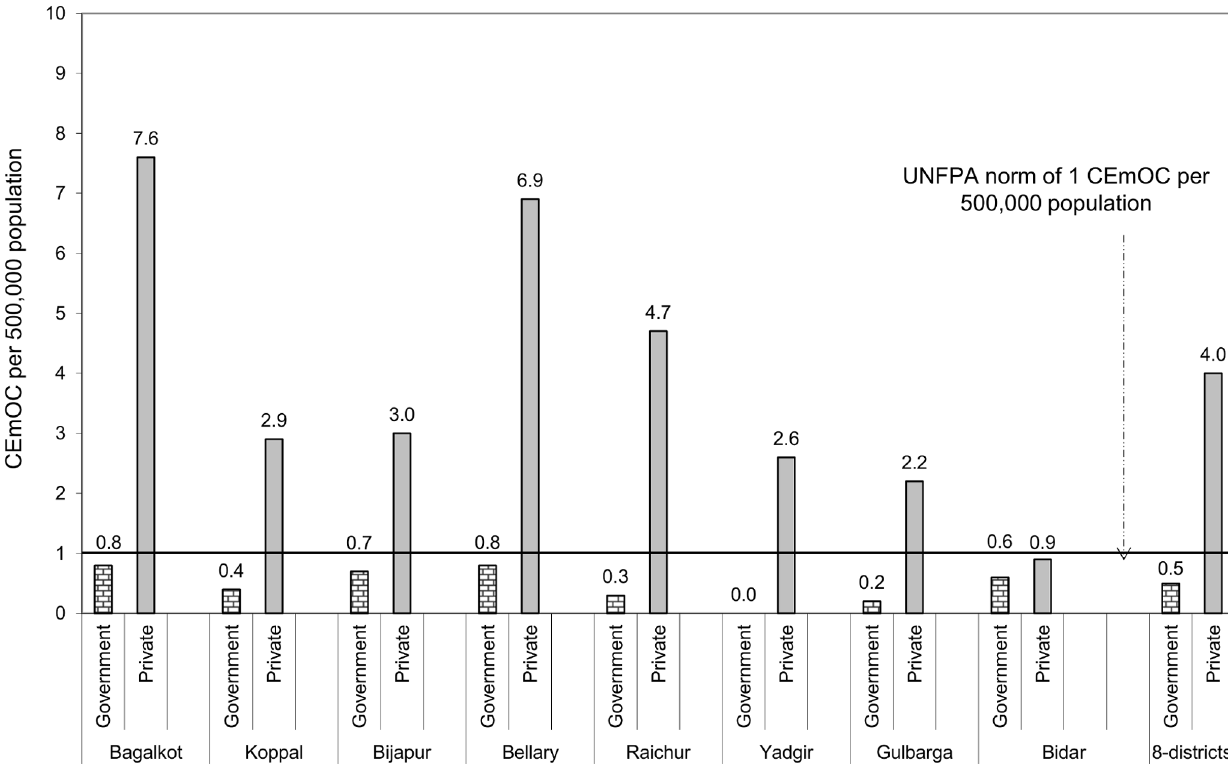
Figure 2. Distribution of CEmOC facilities per 500,000 population by district, northern Karnataka, 2010. CEmOC=Comprehensive Emergency Obstetric